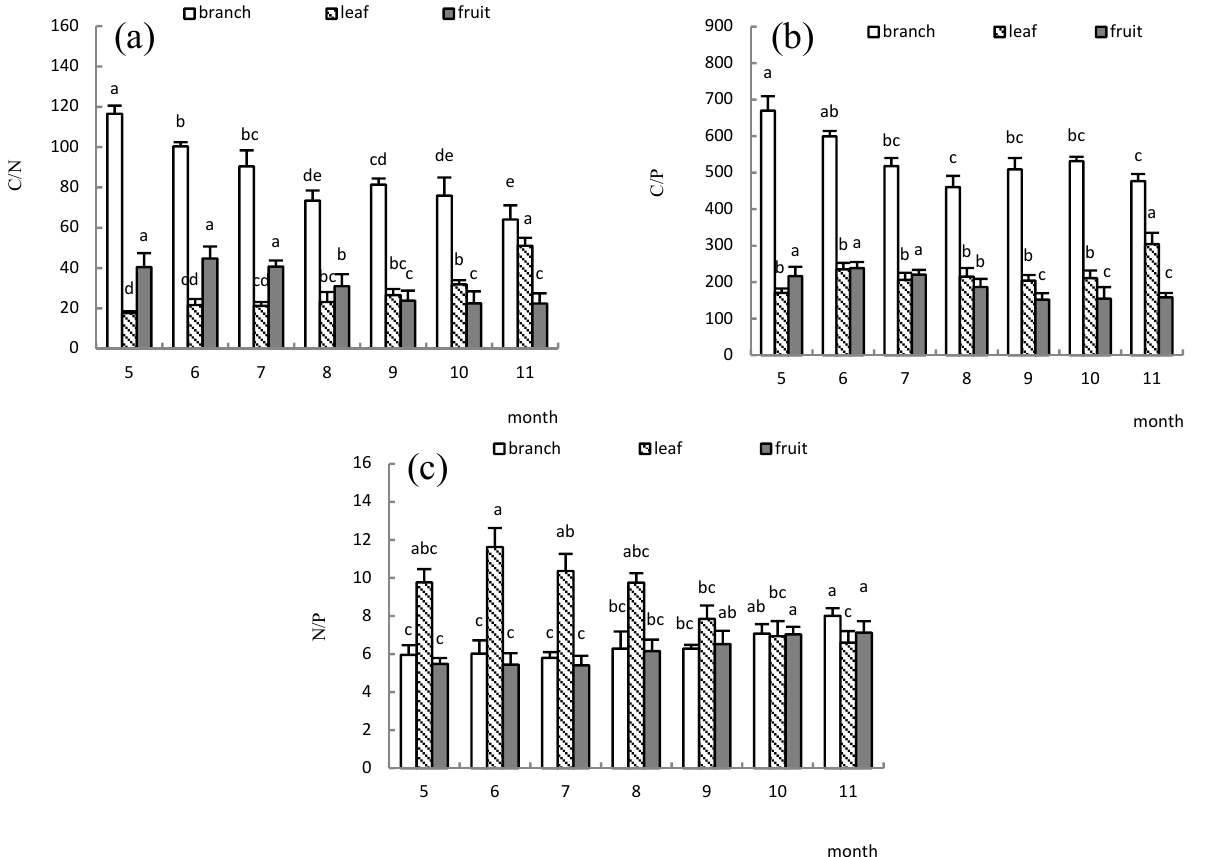
Figure 3. Monthly dynamic of C/N ( a ), C/P ( b ), N/P ( c ) ratios in different organs of female plants of F. velutina . Note: Means of different months not sharing the same letter indicated significant differences at an alpha level of 0.05, according to an LSD test.